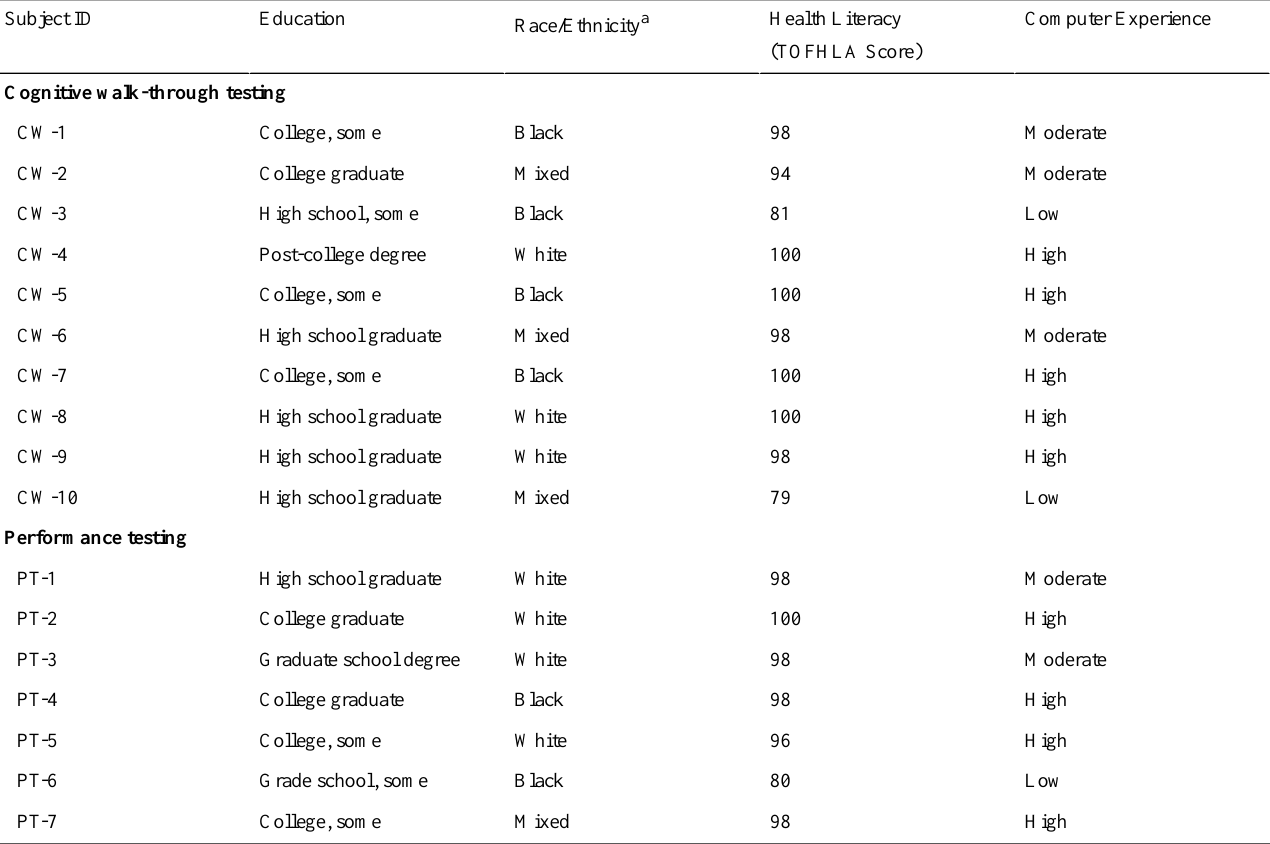
Table 2. Characteristics of subjects in both usability testing sessions